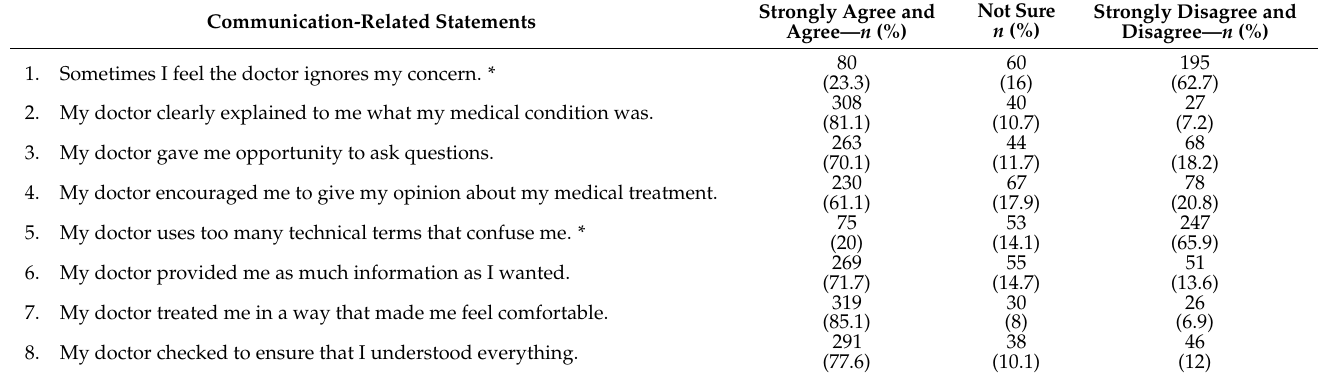
Table 2. Participants’ response to communication-related statements.